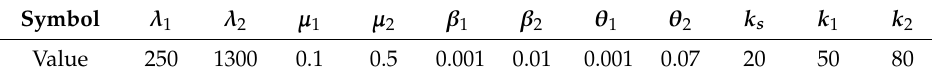
Table 1. Parameters and controller gains of the proposed